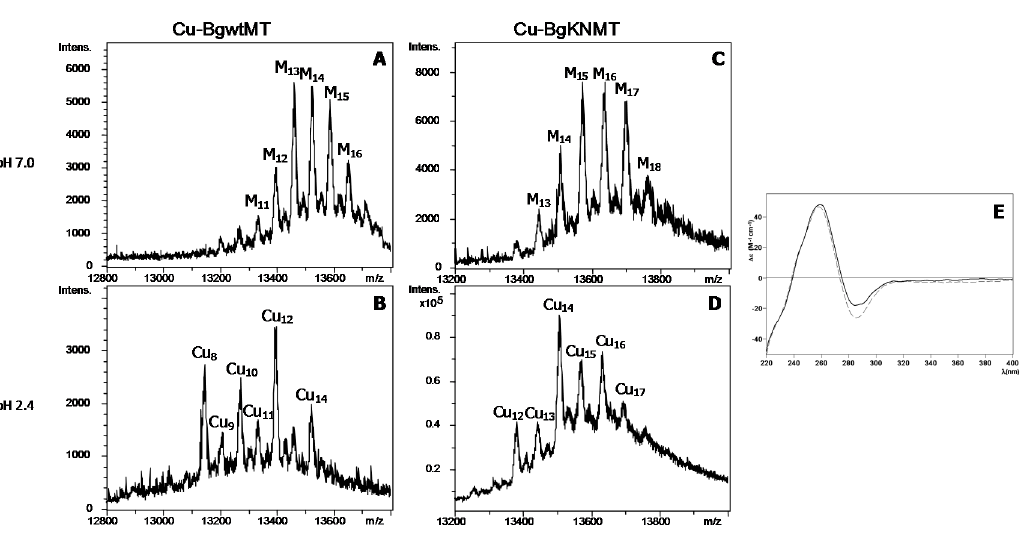
Figure 6. MS and CD spectra of Cu-BgMT: ( A – D ) Deconvoluted ESI-MS spectra of recombinant Cu-BgwtMT and Cu-BgKNMT, recorded at neutral (7.0) and acidic (2.4) pH. M denotes mixture of Zn and Cu ( E ) CD spectra of each Cu-preparation: BgwtMT (solid line) and BgKNMT (dashed).